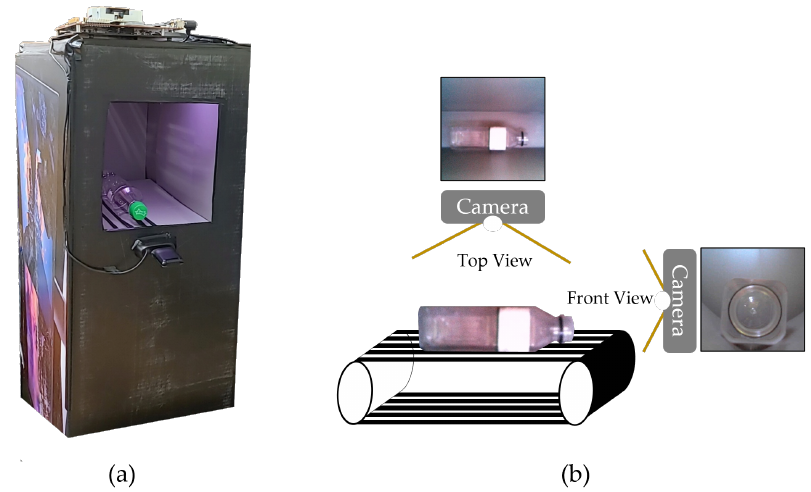
Figure 2. Hardware setup for constructing dataset: ( a ) Prototype RVM; ( b ) Settings for capturing dual image.